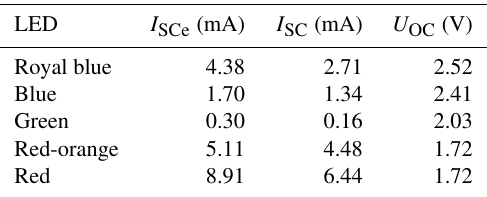
Table 4. Estimated and measured short circuit current and open- circuit